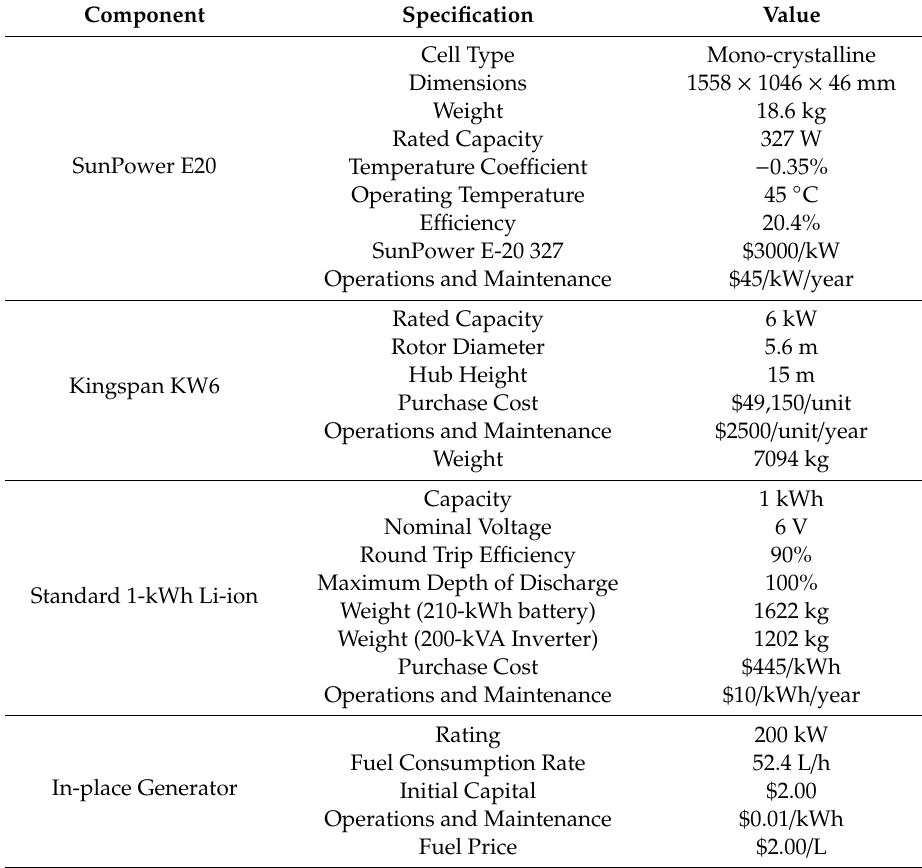
Table 3. HES (hybrid energy system) model component specifications and HOMER (Hybrid Optimization Model for Multiple Energy Resources) system inputs